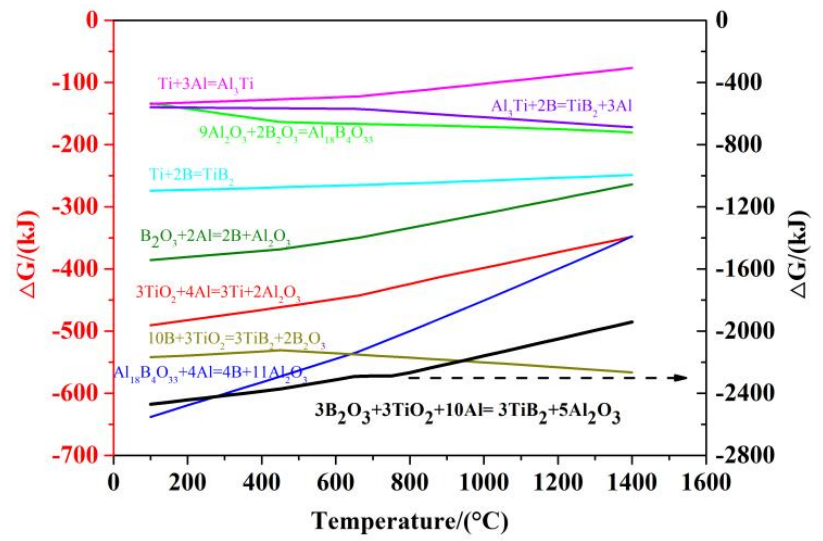
Figure 9. The standard Gibbs energy values corresponding to Reactions (1) and (3)–(10), as a function of temperature.